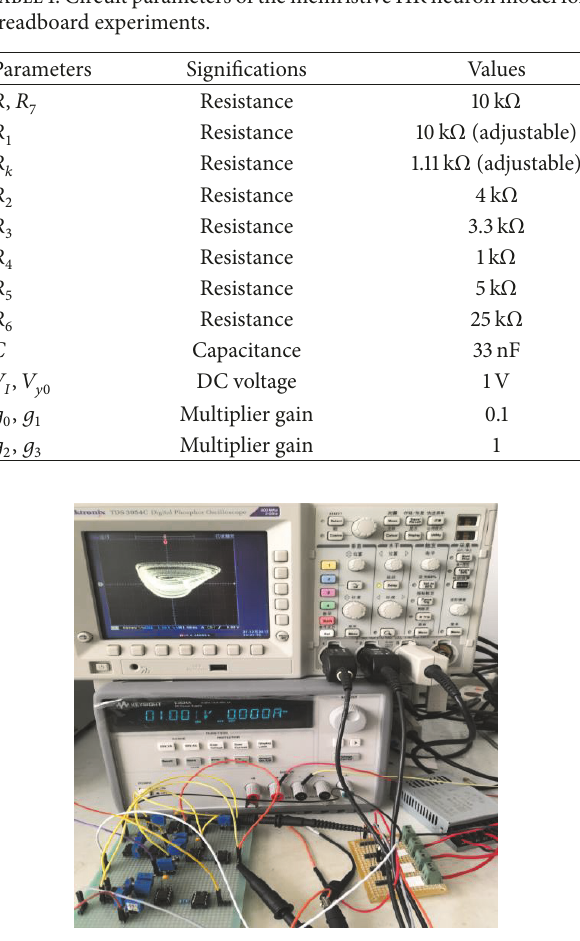
Figure 10: Photograph of the experimental breadboard and typical chaotic attractor captured by the digital oscilloscope.